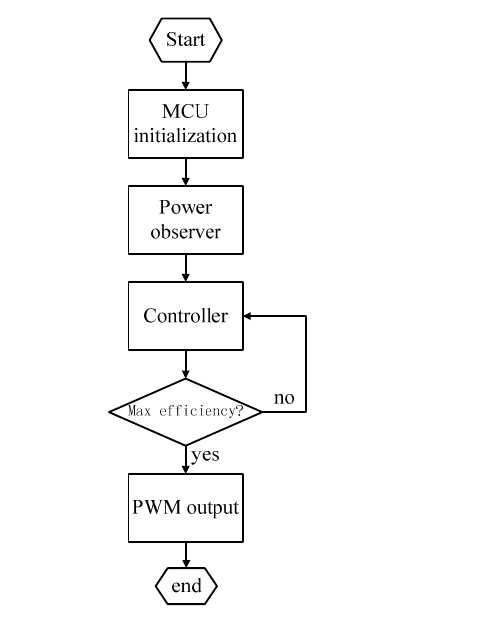
Figure 4. The main flow chart of the controller for the whole power generation system.